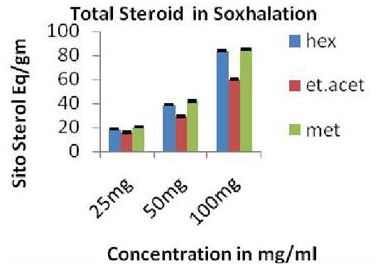
Fig. 5. Total flavonoid content in soxhlation Fig. 6. Total steroid content in soxhlation